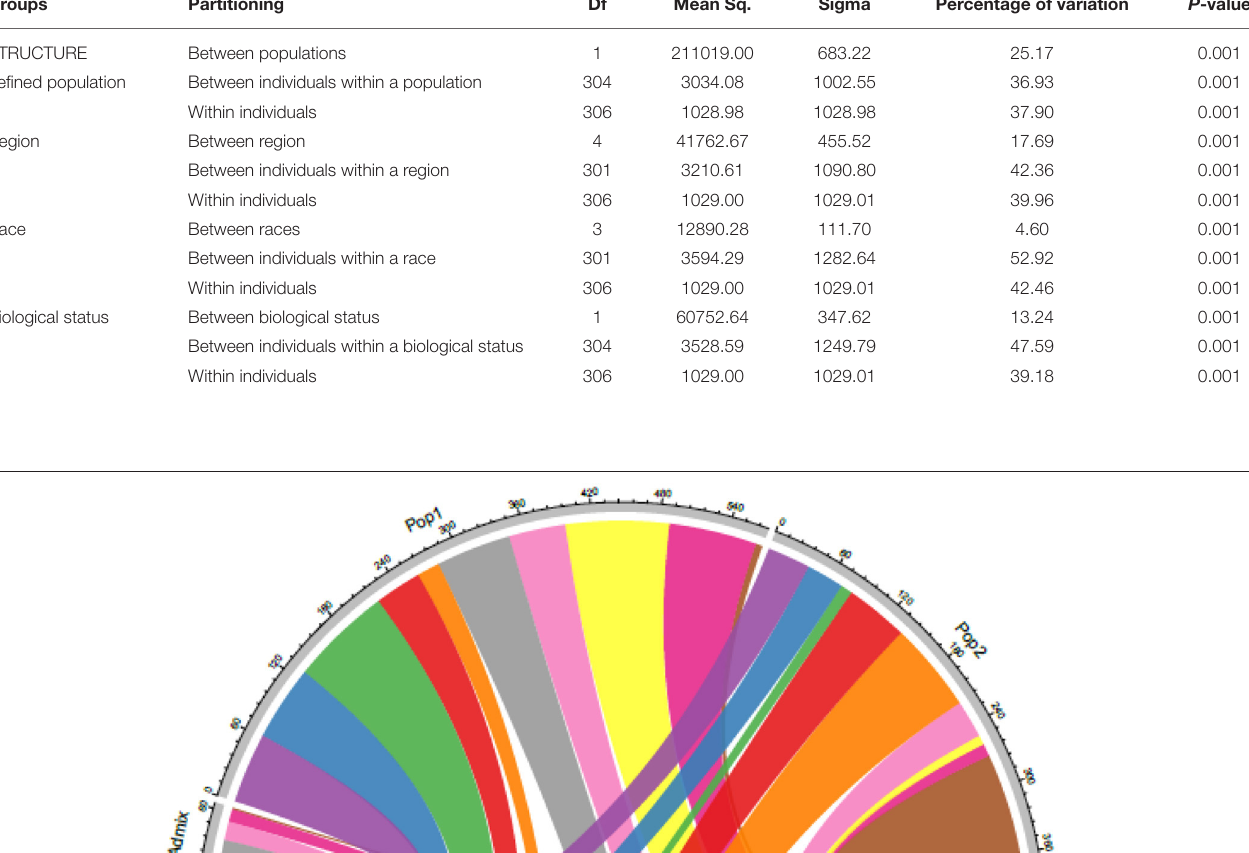
TABLE 6 | Analysis of molecular variance (AMOVA), using DArTseq markers among STRUCTURE populations, region, races, and biological status of the finger millet diversity panel. Groups